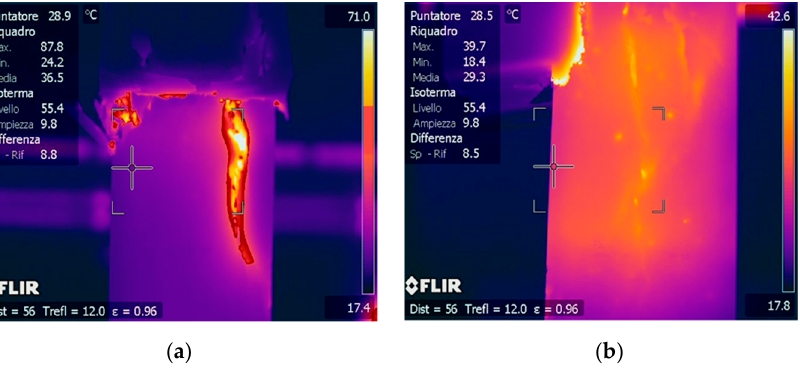
Figure 11. Thermographic images of the internal ( a ) and external ( b ) compressed edges of specimen S2.